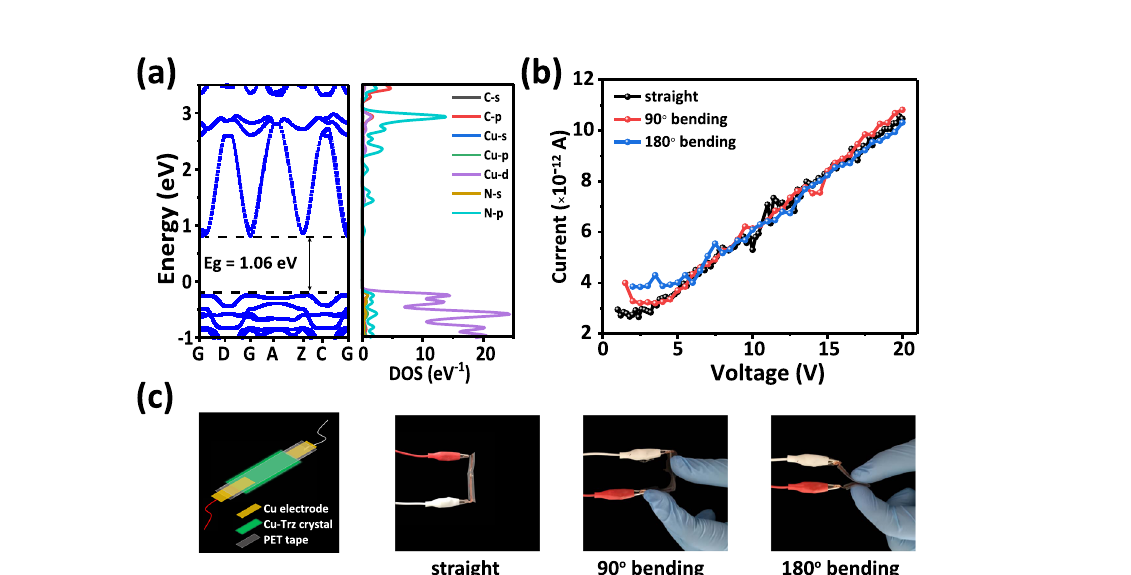
Fig. 5 | The band structure and conductivity of crystal. a Calculated electronic band structures and densities of states for Cu-Trz. b The current-voltage ( I-V ) curves of different bending crystals. c The experiments scheme of the two-contact